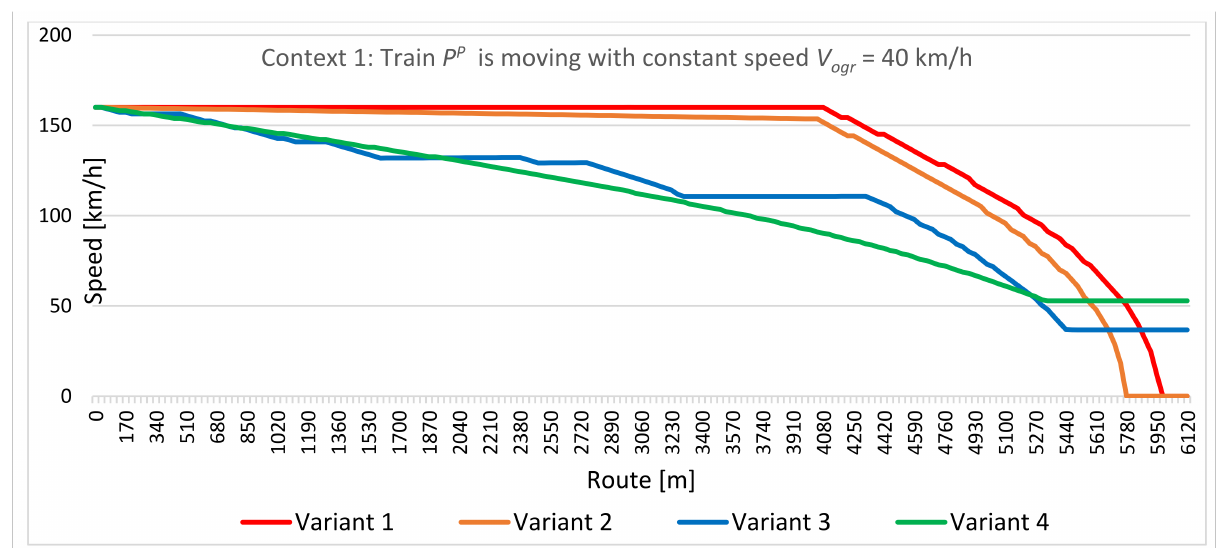
Figure 9. Speed profiles P N for different movement variants; context 1 (source: own calculations).